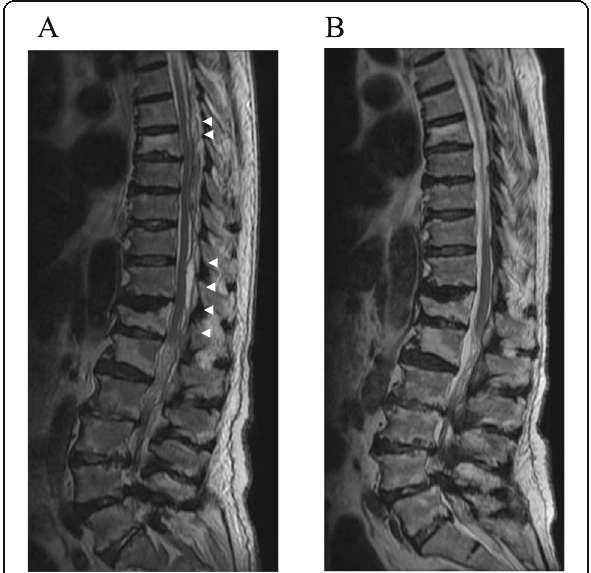
Fig. 2 a Magnetic resonance imaging (MRI; T2) performed a day after fluoroscopy-guided percutaneous puncture. The volume of fluid in the epidural space has decreased and the spinal cord compression has been relieved (arrow). b MRI (T2) performed after 3 weeks. The epidural fluid pool has completely